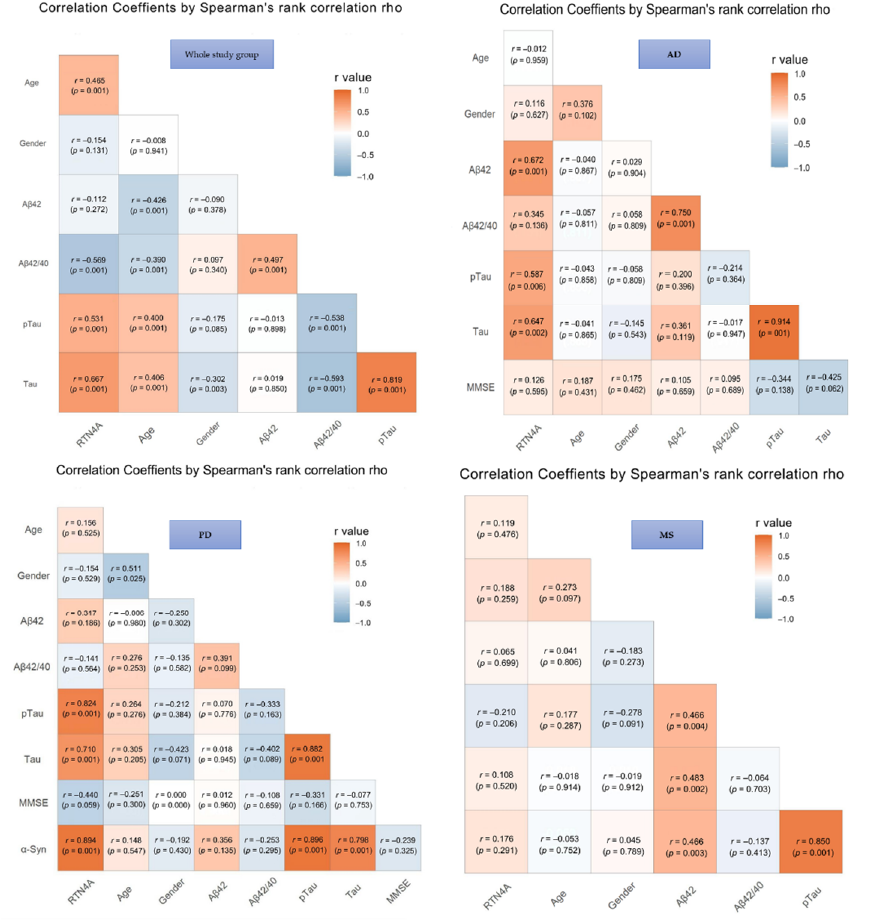
Figure 3. Associations between Reticulon 4 (RTN-4) and tested variables. Abbreviations: Alzheimer’s disease (AD), Parkinson disease (PD), Multiple sclerosis (MS), Control group (CTRL), MMSE – mini-mental state examination.